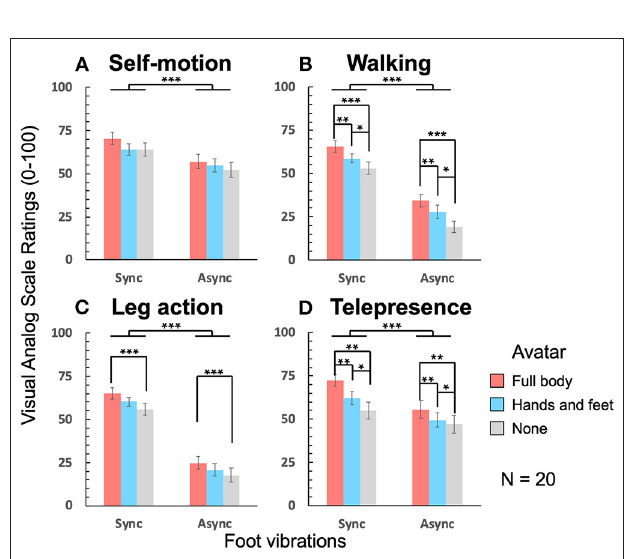
FIGURE 6 | Results of experiment 1. (A) Self-motion, (B) walking sensation, (C) leg action sensation, and (D) telepresence. Bar plots indicate mean ± SEM. * p < 0.05; ** p < 0.01; *** p <